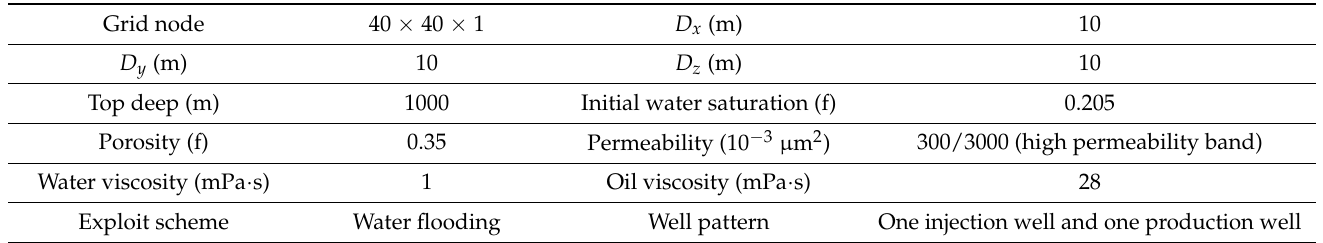
Table 2. Simulation model parameters.